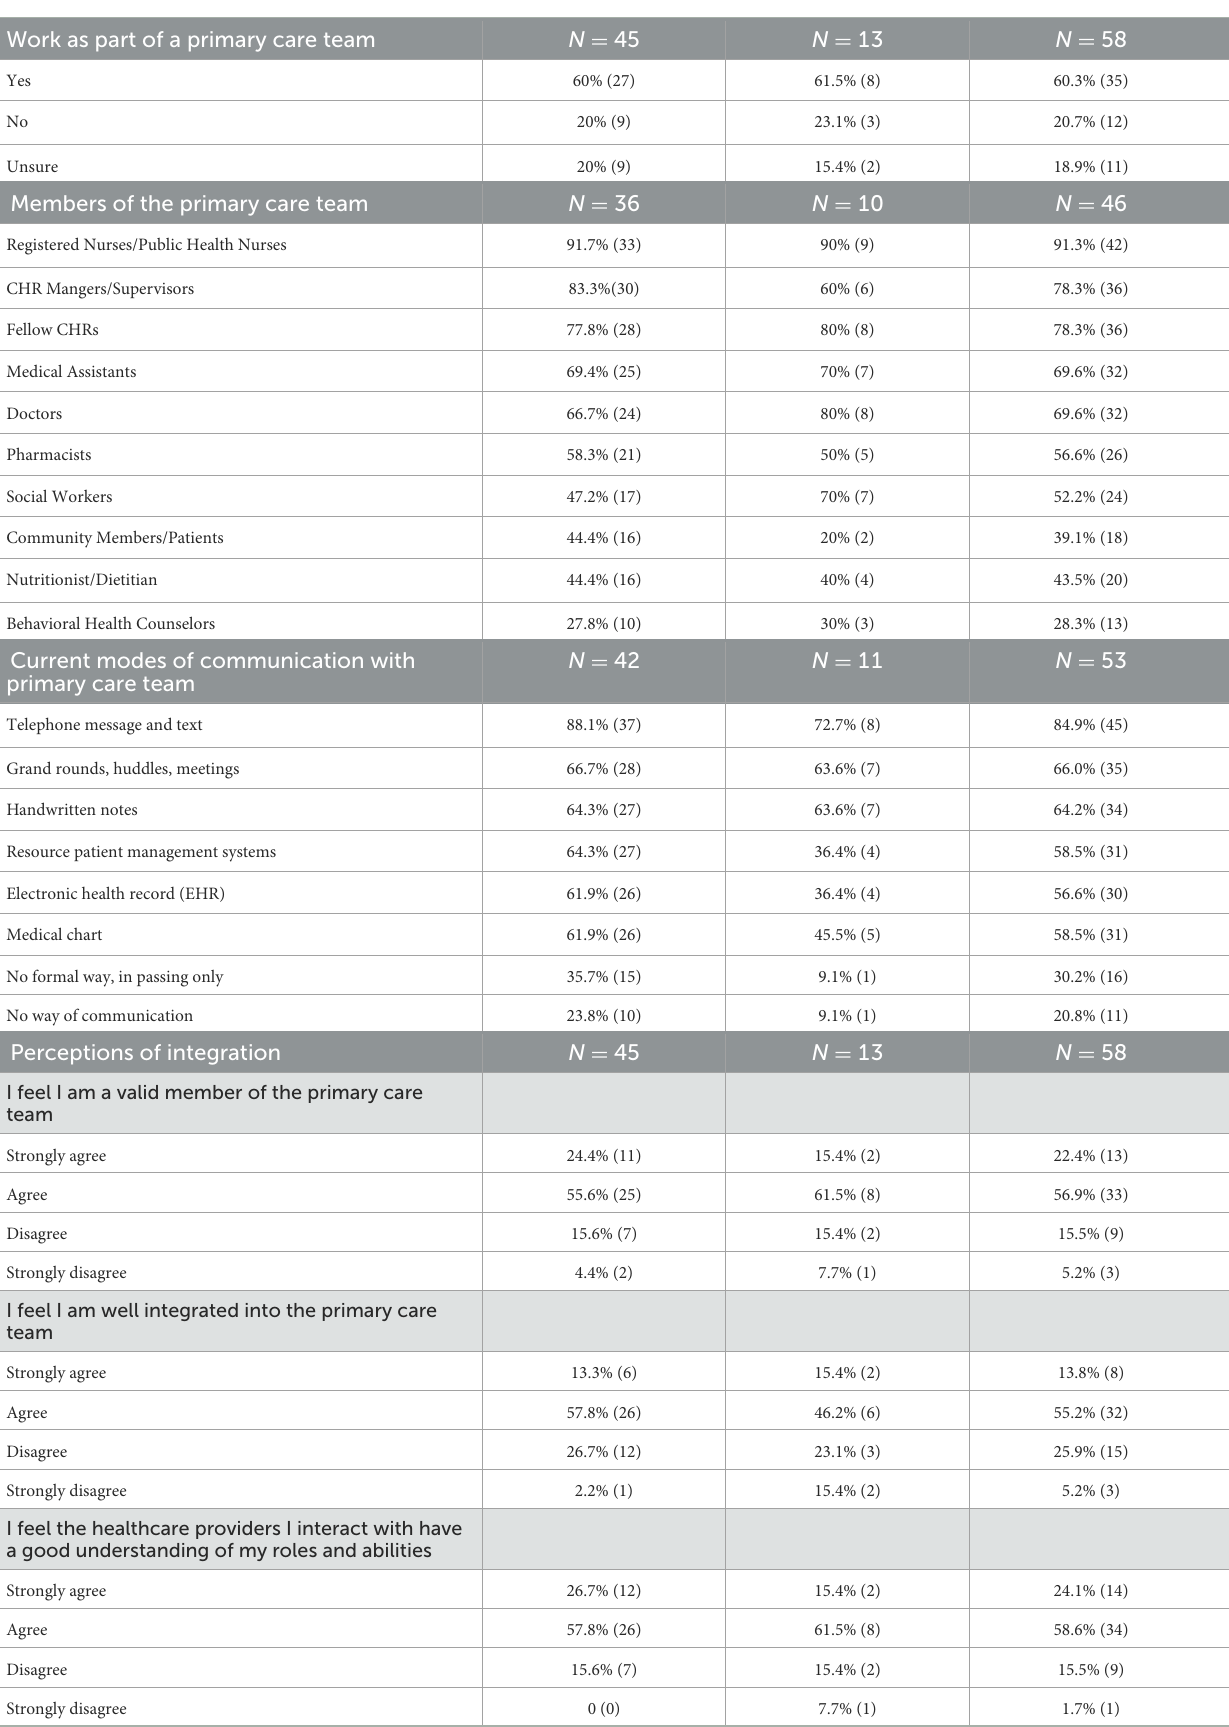
TABLE 2 CHR program integration within health systems and